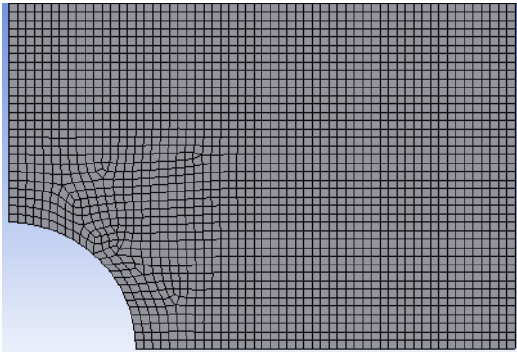
Figure 15. Finite element mesh around the hole.